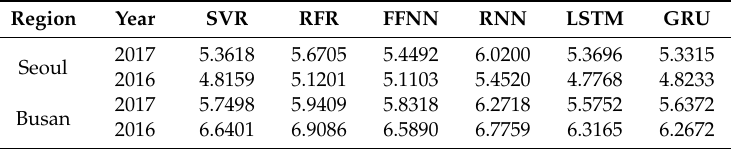
Table 3. RMSE of daily solar radiation for di ff erent models.